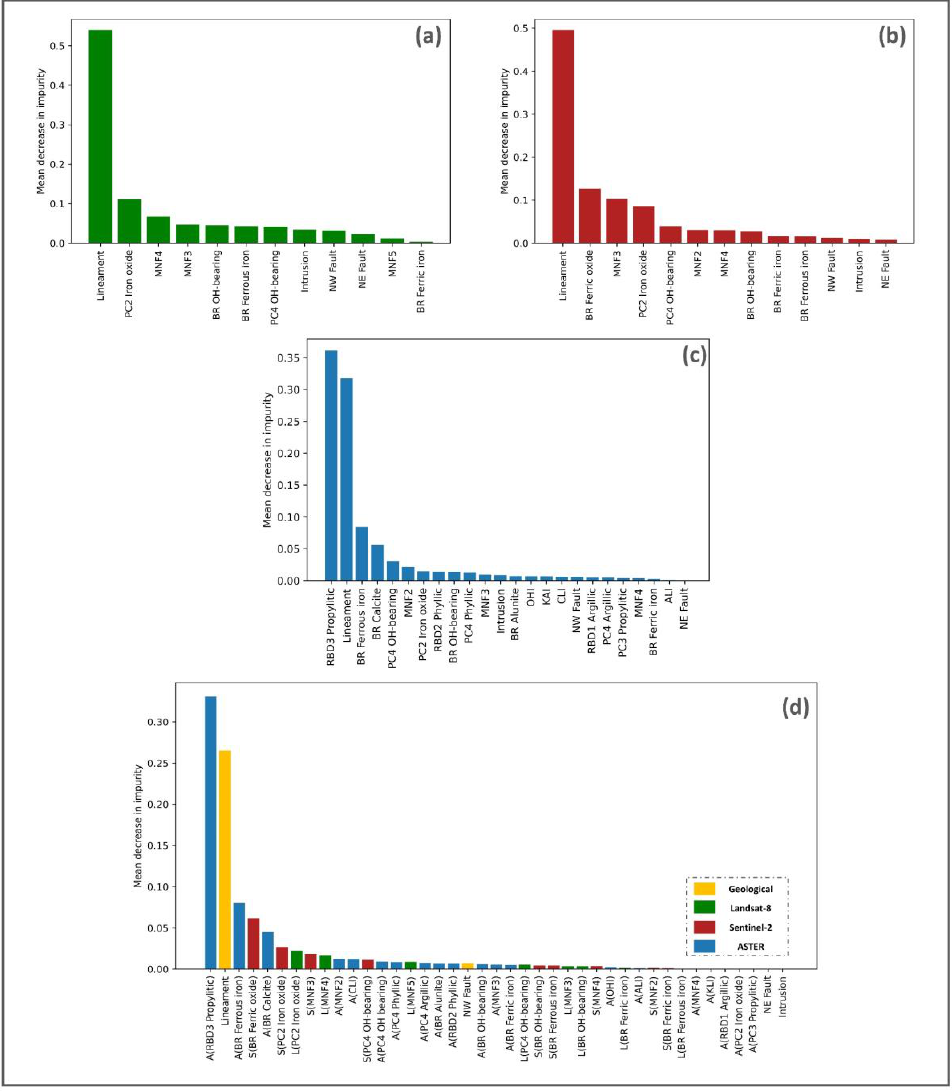
Figure 16. RF model important feature analysis results: ( a ) Landsat-8; ( b ) Sentinel-2; ( c ) ASTER; ( d ) data integration (Symbol ‘L’ represents Landsat-8; ‘S’ represents Sentinel-2; ‘A’ represents